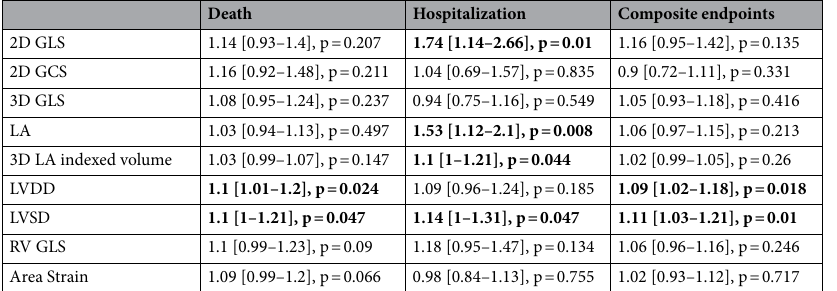
Table 7. Estimated relation of STE analysis and 3D Echo data individually adjusted for age and cubic natural splines of LVEF. Significant values are in bold. 2D GLS Two-dimensional global longitudinal strain, 2D GCS Two-dimensional global circumferential strain, 3D GLS Three-dimensional global longitudinal strain, LA Left atrium, 3D LA indexed volume Three-dimensional left atrium indexed volume, LVDD Left ventricular diastolic diameter, LVSD Left ventricular systolic diameter, RV GLS Right ventricular global longitudinal